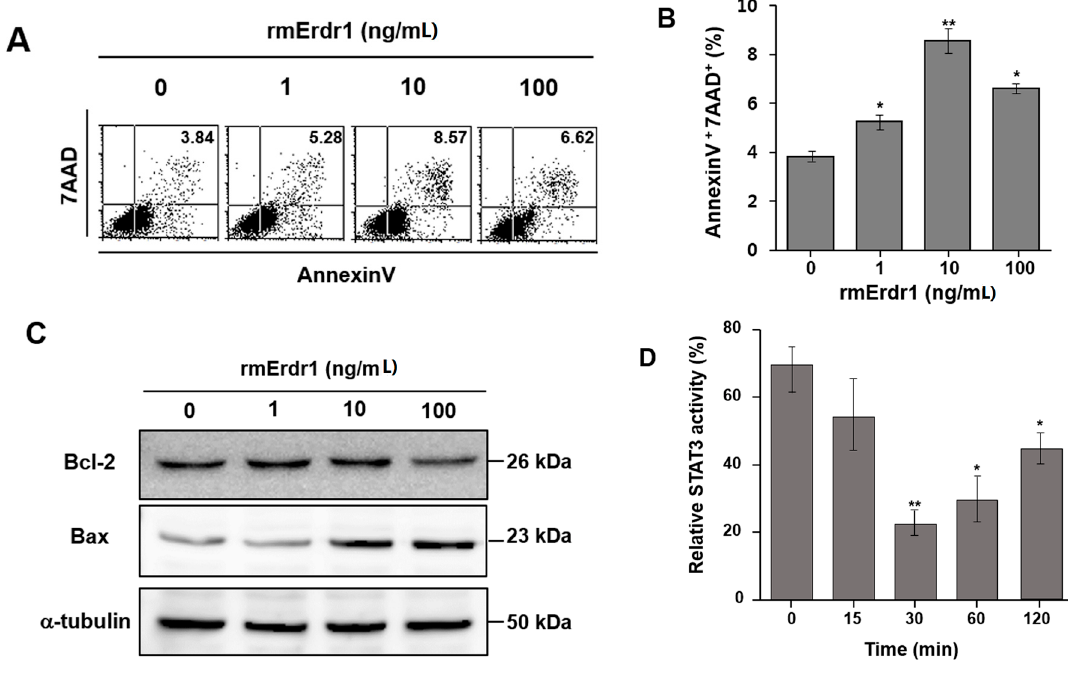
Figure 3. Erdr1 induces apoptosis via regulation of Bcl-2 and Bax in murine melanoma cell lines. ( A ) B16F10 cells were treated with different doses (0, 1, 10, and 100 ng/mL) of recombinant murine Erdr1 for 24 h. Staining with 7-AAD and Annexin V was performed to measure apoptosis induced by recombinant murine Erdr1. After staining, stained cells were analyzed with flow cytometry analysis. The image shows one of the representative experiments of three experiments performed independently; ( B ) Flow cytometry analysis data were converted into a bar graph. The data represents the mean ± SD of one of three independent experiments. *, p < 0.05 control vs. recombinant murine Erdr1 treatment groups. **, p < 0.01 control vs. recombinant murine Erdr1 treatment groups; ( C ) Bax and Bcl-2 were measured using Western blot. B16F10 cells were treated with different doses (0, 1, 10, and 100 ng/mL) of Erdr1 for 24 h. After lysis, equal amounts of protein lysates were loaded onto an acrylamide gel. To detect Bax and Bcl-2 expression, rabbit anti- mouse Bax antibody and rabbit anti- mouse Bcl-2 antibody were used; ( D ) The activity of STAT3 was measured in melanoma B16F10 cells treated with or without recombinant murine Erdr1 (10 ng/mL) after 0, 15, 30, 60, and 120 min. Cells were collected and lysed with lysis buffer. Subsequently, lysates were incubated with an oligonucleotide containing a STAT3 consensus binding site. After incubation, STAT3 activity was measured using an ELISA based on horseradish peroxidase (HRP) reaction. The data represents the mean ± SD of one of three independent experiments. *, p < 0.05 control vs. recombinant murine Erdr1 treatment groups. **, p < 0.01 control vs. recombinant murine Erdr1 treatment groups.